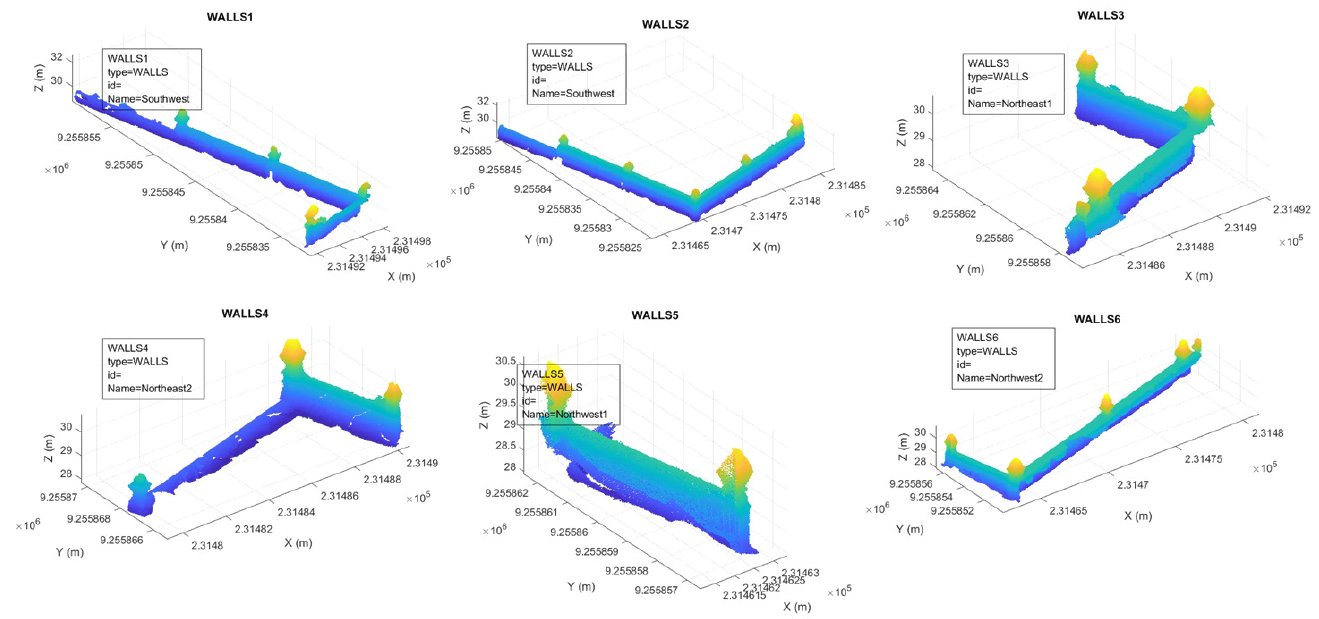
Figure 4. Result of the segmentation and semantic annotation process for each object for the class “WALLS”.